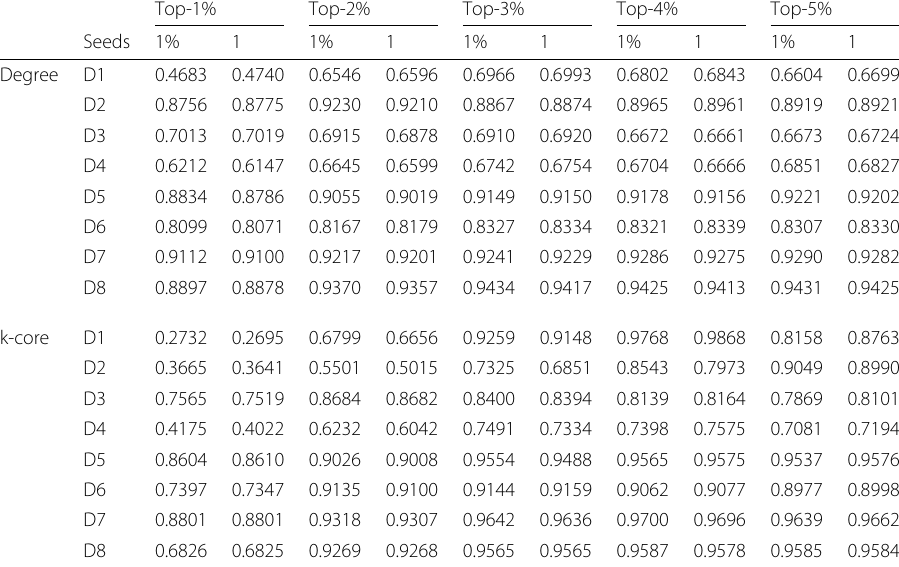
Table 3 OSim values (SIR epidemic) in terms of degree centrality and k-core for two maxRD versions: (i) the number of initial seeds is equal to 1% and (ii) the number of initial seeds is equal to